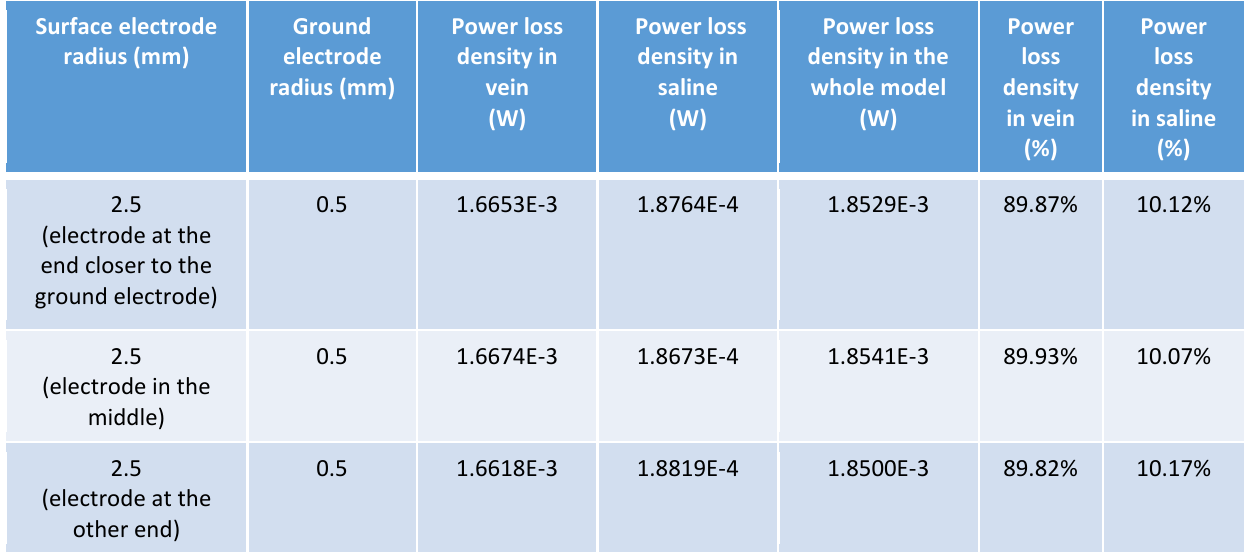
Table.4: Volumetric power loss density measurements at 1 MHz with one of the 28 surface electrodes as terminal (7 electrodes in 4